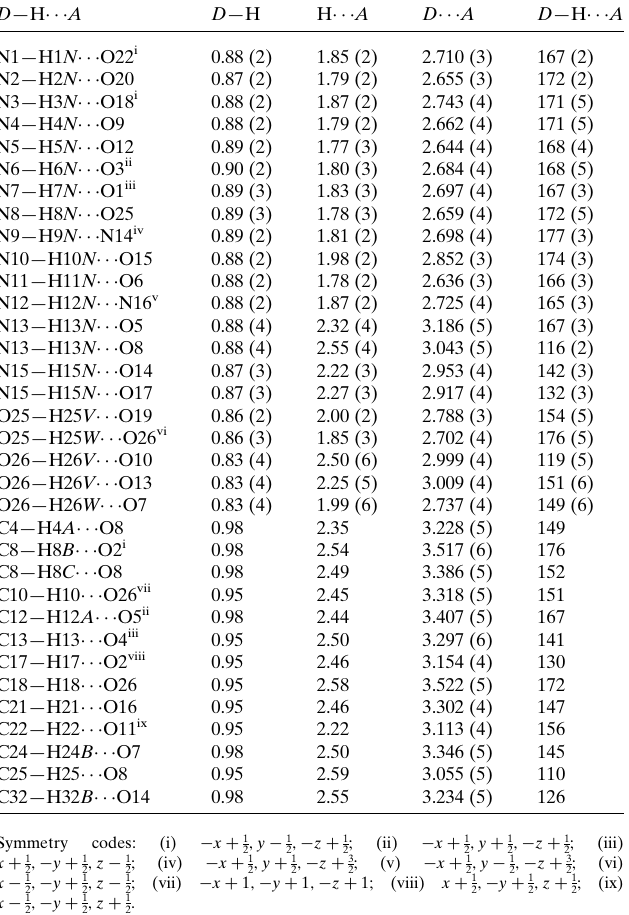
hydrogen bonds (Table 1) involving three categories of oxygen atoms of the polyanion: O hydrogen bonds from N9 and N12 link (C neutral molecules. The packing is consolidated by weak C— H (cid:2) (cid:2) (cid:2) O links (Table 1). The overall hydrogen-bonding topology is an infinite three-dimensional network.